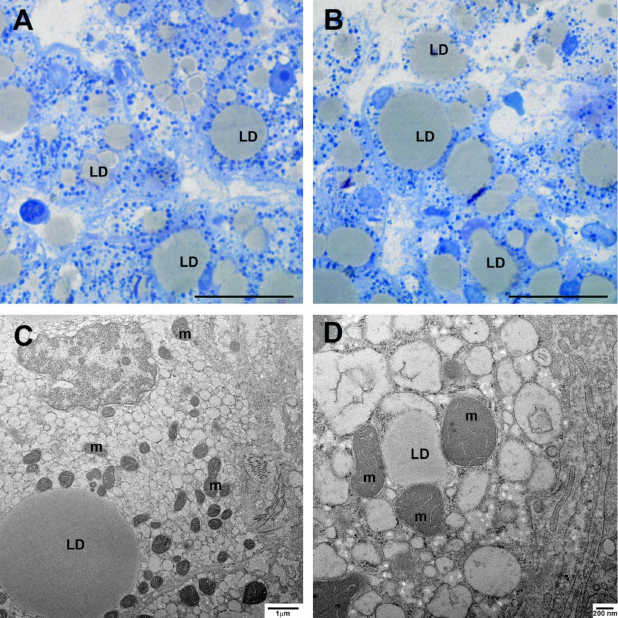
Figure 5. Lipid accumulation and mitochondria changes. ( A , B ) Light micrographs of liver biopsies semithin sections show the presence of abundant lipid droplets into hepatocytes and dark blue stained mitochondria. ( C , D ) The ultrastructural analysis highlights the condensed state of mitochondria, which display compacted matrix and enlarged cristae; mitochondria in strict contact with lipid droplets are visible ( D ). m, mitochondrion; LD, lipid droplet. Scale bars: A , B = 7 µ